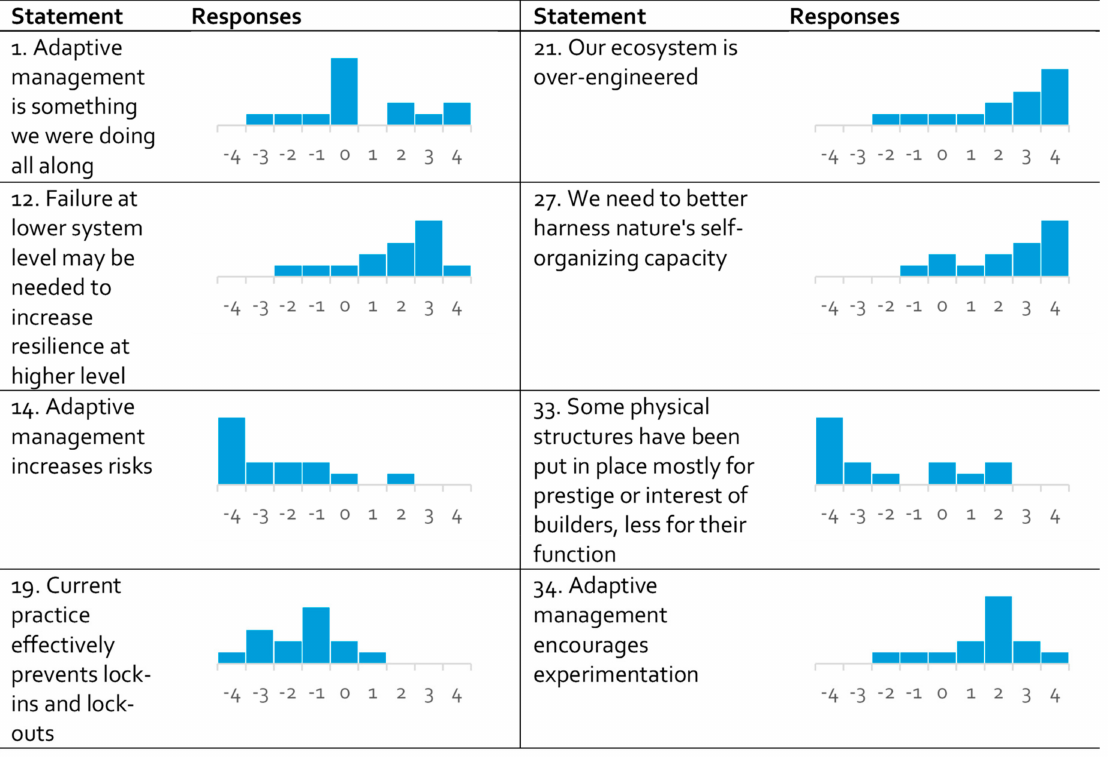
Figure 8. Responses to selected numbered Q